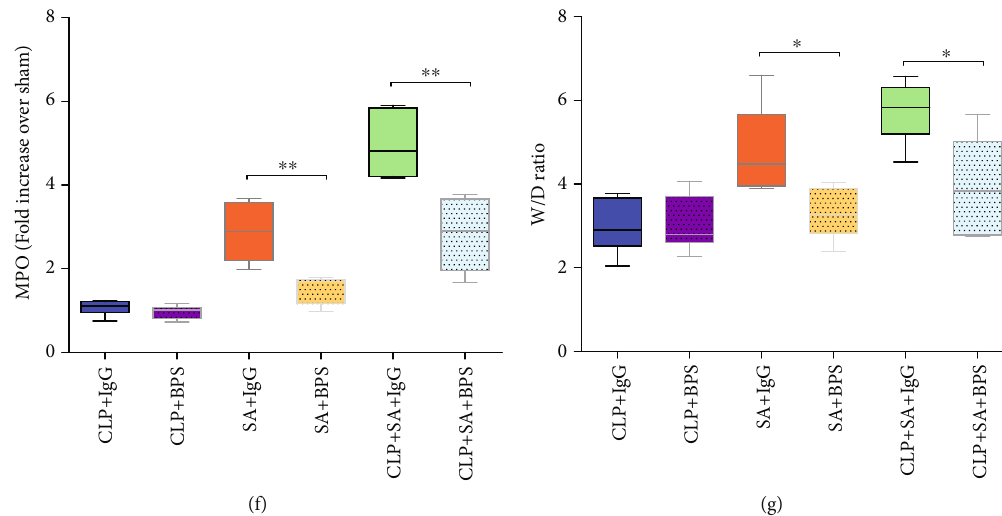
Figure 1: (a) Experimental procedure. We randomized mice into 6 groups, including 4 receiving CLP at D0 and 2 receiving sham operation. At 3 days later (D3) or at D0 in the sham operation group, mice were given intratracheal injection with P. aeruginosa (PA, 5 × 10 7 CFU) or S. aureus (SA, 5 × 10 7 CFU). Two hours after the bacterial hit or the second bacterial hit, basil polysaccharide or IgG was injected intraperitoneally as an intervention. We collected lung tissues, blood, and BALF at 24 h after a bacterial infection or secondary bacterial infection for analysis. In the 10-day experimental period, we recorded the mortality rates of all groups to analyze the survival. (b) The mortality rates were monitored for 10 days after the challenge with S. aureus ( n = 15 mice/group). (c, d) Lung or blood bacterial CFU in each group after administration with S. aureus ( n = 5 mice/group). (e – g) Lung injury assessment indicators such as protein in BALF, myeloperoxidase, and wet/dry weight ratio in the lung were measured after challenge with S. aureus ( n = 5 mice/group). Log-rank (Mantel-Cox) test was performed to analyze survival curves. Values were presented in the manner of mean ± SD , while one-way ANOVA as well as LSD multiple comparisons test was adopted for data analysis. # p < 0 : 05 , compared with S. aureus infection treated with basil polysaccharide. ▲ p < 0 : 05 , compared with CLP-surgery mice upon secondary S. aureus infection treated with basil polysaccharide. ∗ p < 0 : 05 , ∗∗ p < 0 : 01 , and ∗∗∗ p < 0 : 001 , upon one-way ANOVA as well as LSD multiple comparisons. Compared with S. aureus infection treated with basil polysaccharide group or CLP-surgery mice upon secondary S. aureus infection treated with the basil polysaccharide